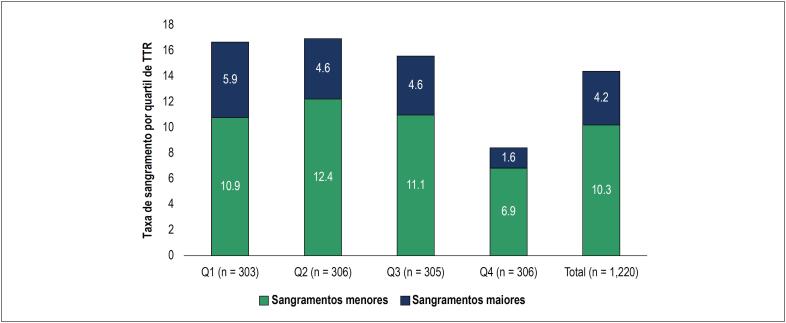
Taxa de sangramento por quartil de TTR.